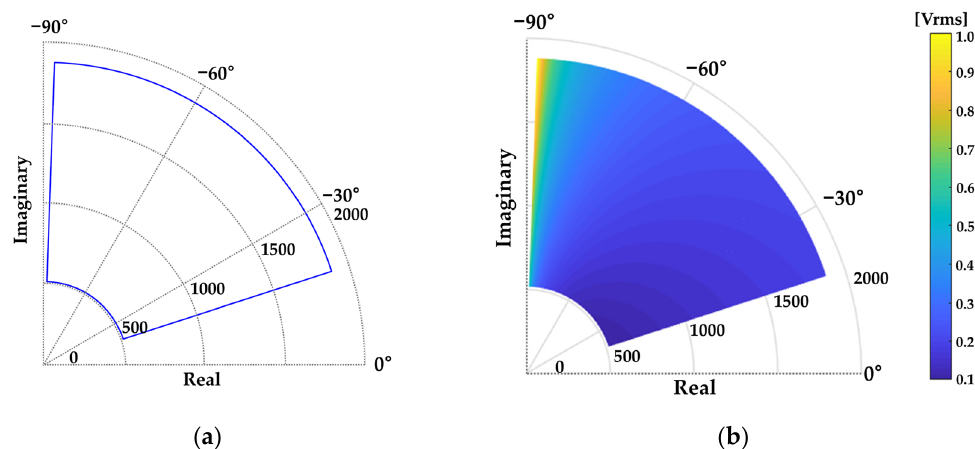
Figure 1. Analysis of the impedance distribution and the required output voltage for the multichannel acoustic transducer: ( a ) the impedance distribution measured by the experiment; ( b ) the output voltage distribution for the required output power.